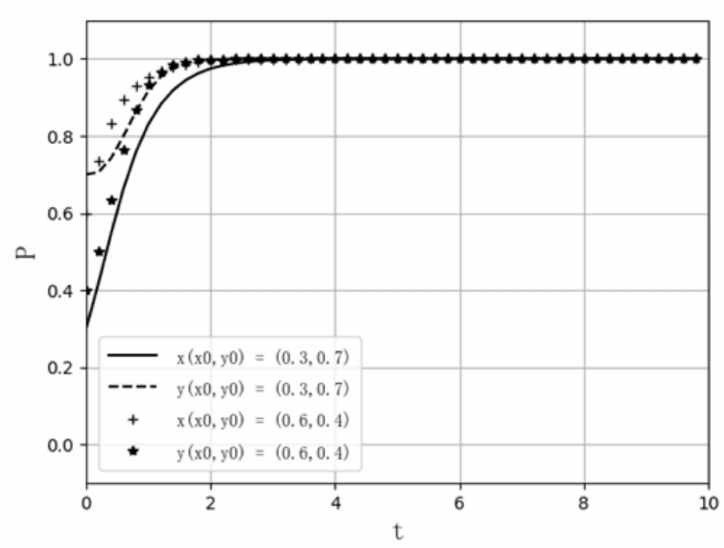
Figure 4. Path diagram of the evolutionary game on abandoned land transfer between farmers and agricultural enterprises under constraints ( I 2 + B > I 3 − C and I 2 + F + T 2 > I 1 + T 1 , I 1 > I 3 ).